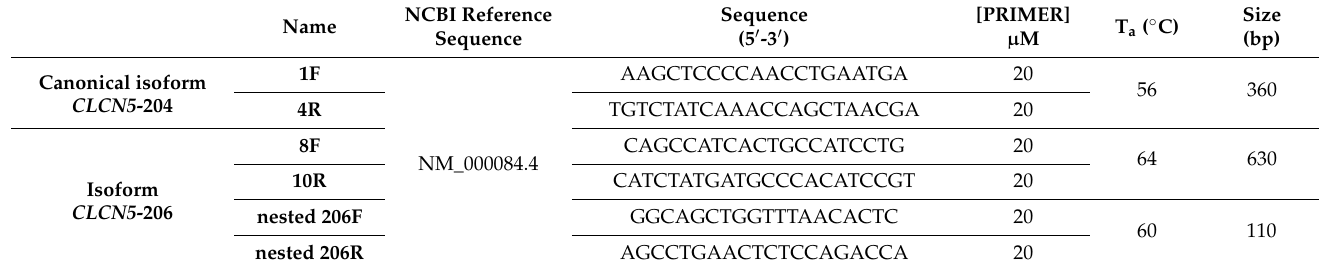
Table 4. Primers used for RT/PCR analysis of the CLCN5 mRNA.